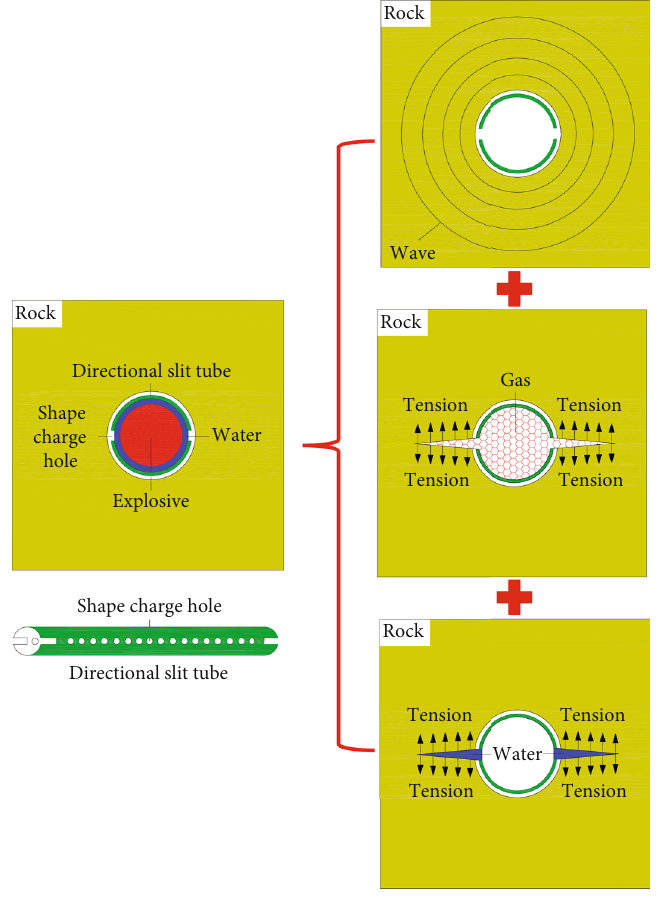
Figure 2: Charge structure and directional roof-cutting mechanism of shaped charge hydraulic blasting